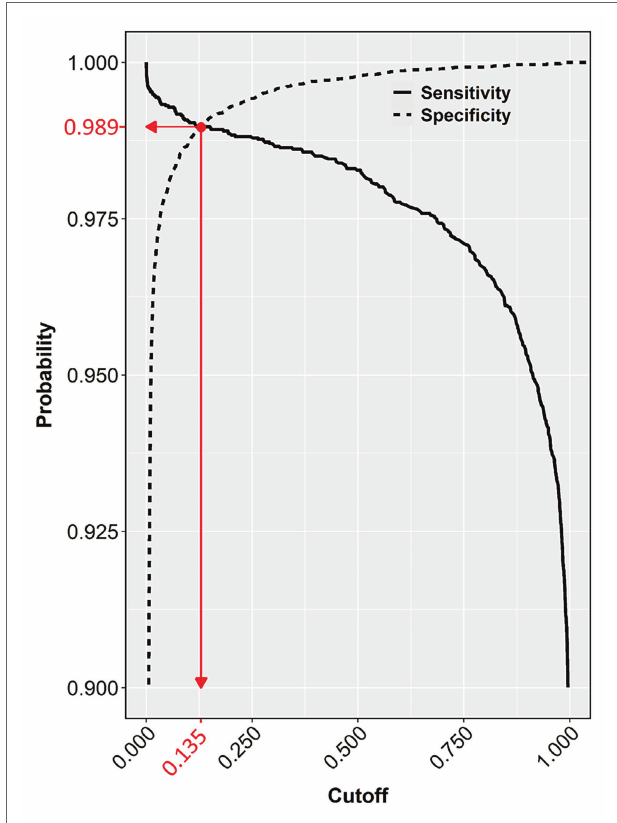
FIGURE 6 | Sensitivity and specificity of the test dataset across the entire cutoff range (0–1). The crossing point (red dot) of the two curves indicates the selected cutoff value (0.135), at the zenith of the TP (0.9888) and TN rates (0.9882), which corresponds to the nadir of FP and FN rates